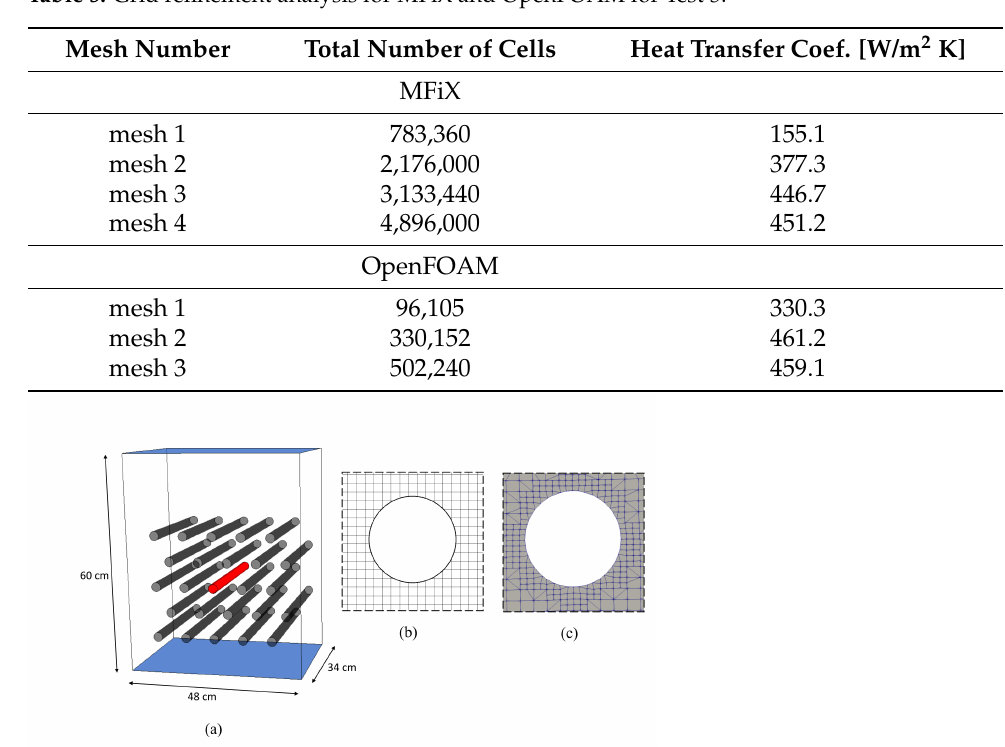
Figure 8. Sketch of the tube bundle and mesh refinement: ( a ) Fluidized bed domain, ( b ) grid refinement around the hot tube using MFiX and ( c ) using